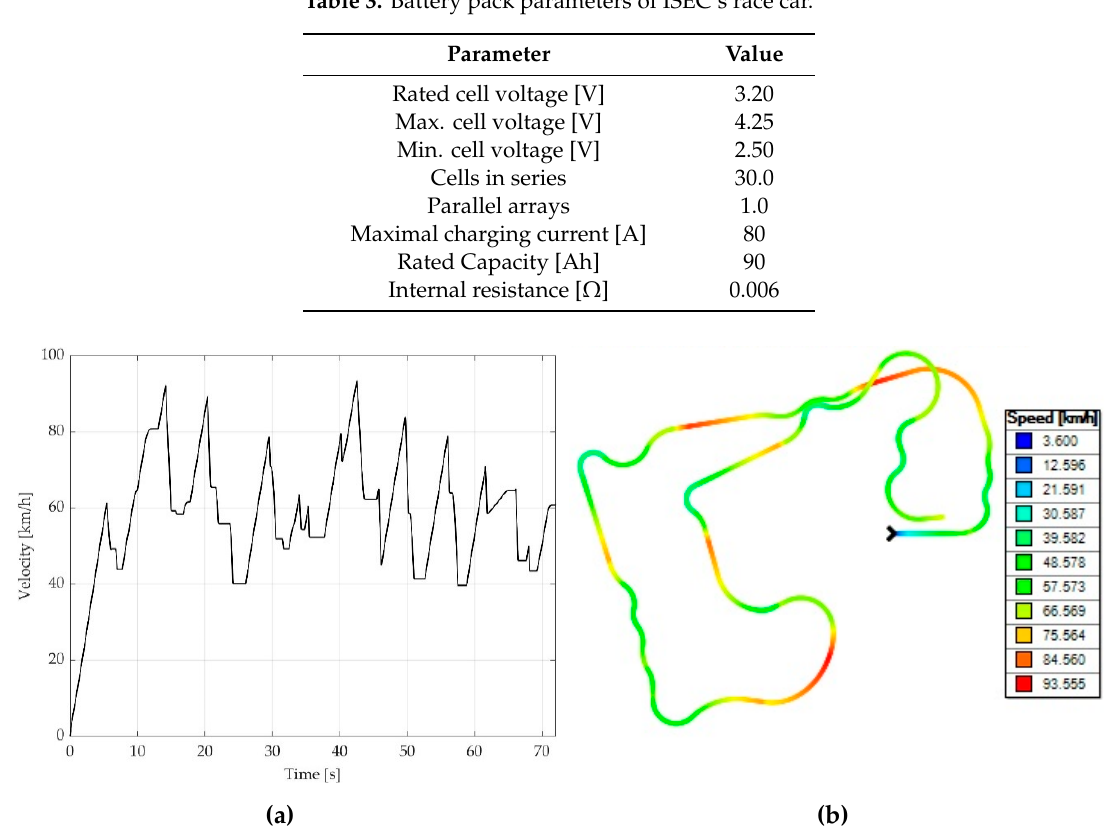
Table 3. Battery pack parameters of ISEC’s race car.